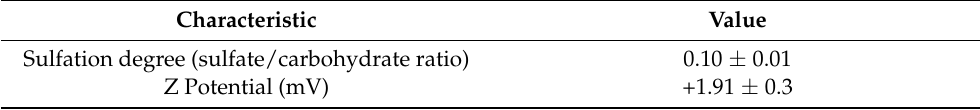
Table 3. Degree of sulfation and Z potential of the CMSP.